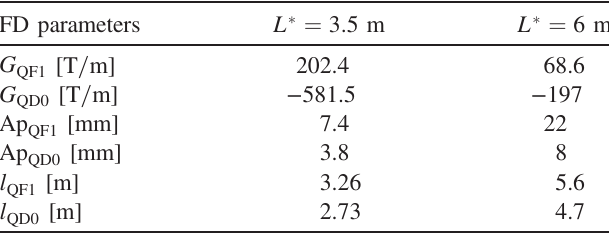
TABLE IV. Final doublet gradient and aperture radius comparison.